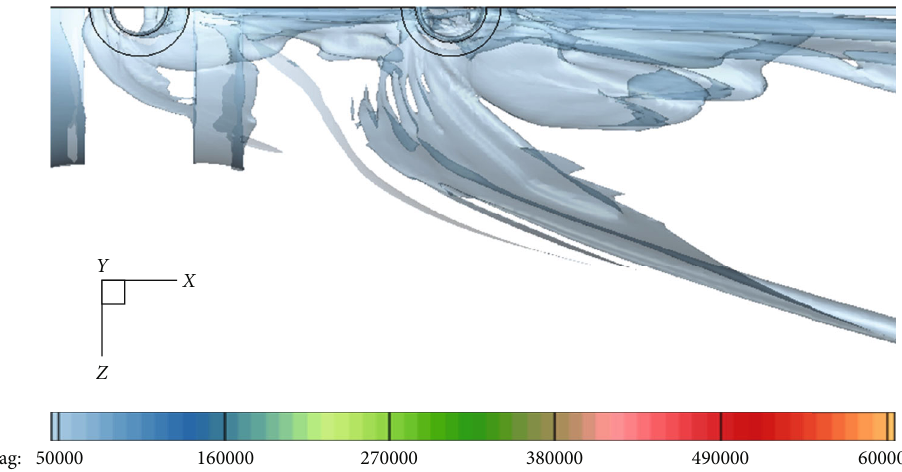
Figure 13: Liutex isosurface with magnitude = 100,000